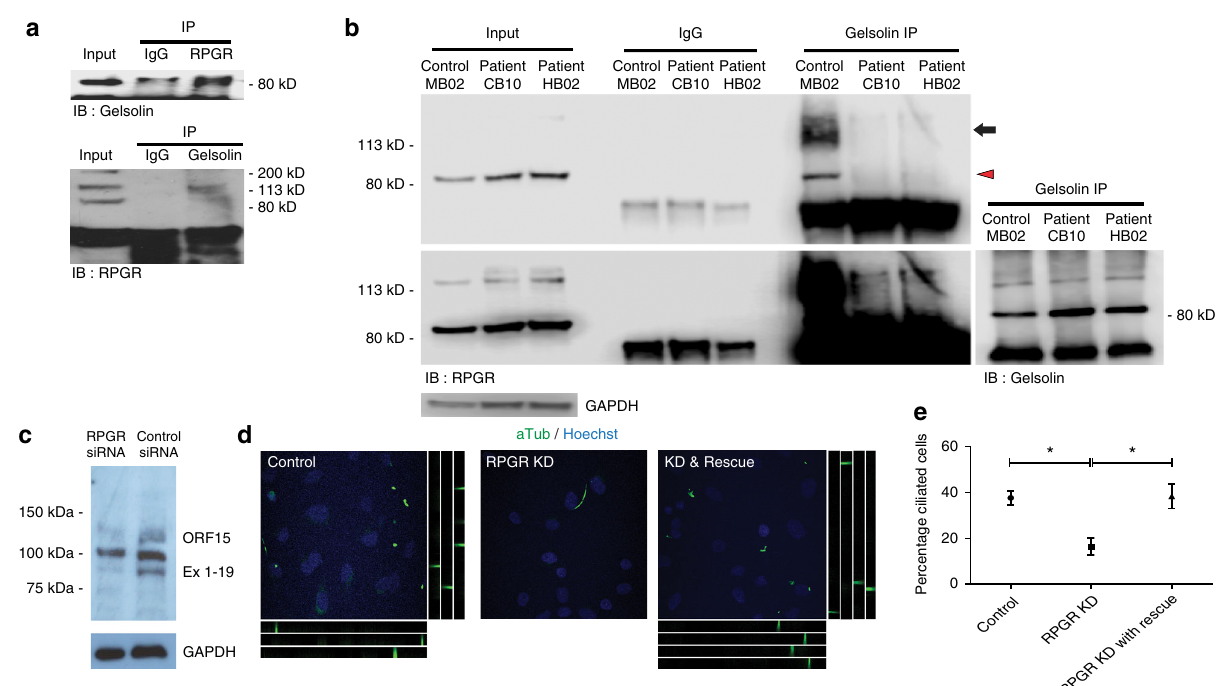
Fig. 6 Loss-of-function and gain-of-function experiments support a role for gelsolin in RPGR mediated cilia maintenance. a Immunoprecipitation (IP) of RPGR ( upper panel) and gelsolin ( lower panel) demonstrates an endogenous RPGR-gelsolin interaction in bovine retina, as evidenced by immunoblotting (IB) showing the presence of gelsolin (86 kD) and the 127 kD retina-speci fi c form of RPGR respectively in the immunoprecipitates. b Immunopreciptation (IP) of gelsolin followed by immunoblotting (IB) for RPGR reveals that the RPGR-gelsolin interaction is present in control iPSC-derived photoreceptors but is perturbed in both XLRP patient-derived RPGR -mutant cultures — note in the righthand set of three lanes that RPGR is present only in the IPs from the control patient. The lower panel shows a longer exposure of the immunoblot to show that both the constitutively-expressed (90 kD, encoded by exons 1 – 19, arrowhead) and retina-speci fi c (127kD — encoded by exons 1 – 14 and speci fi c open reading frame ORF 15, arrow) forms of RPGR are present in the control and mutant cell lysates shown in the three left hand lanes. Far right panel shows equal amounts of gelsolin are pulled down from each sample by gelsolin IP. c siRNA-mediated RPGR knockdown. Note that expression of both the constitutively-expressed (90 kD — Ex 1 – 19) and retina-speci fi c (127 kD — ORF 15) forms of RPGR are reduced by the siRNA while the non-speci fi c band at 100 kD is unaffected in the hTERT-RPE cell line. d , e Immmunolabeling of the hTERT-RPE cell line after siRNA-mediated RPGR knockdown reveals a loss of ciliogenesis (Mean percentage of ciliated cells 37.62% ± 3.113 vs 16.48% ± 3.762 (SEM), unpaired two-tailed t -test, p = 0.0124; identi fi ed by acetylated α -tubulin immunoreactivity in green), as shown by a comparison of the control ( left ) and RPGR knockdown ( centre ) panels. The defect is rescued by overexpression of constitutively active gelsolin, as shown in the right panel (Mean percentage of ciliated cells 16.48% ± 3.762 vs 38.33% ± 5.349 (SEM), unpaired two-tailed t -test, p = 0.0288.) The tracks below and to the right of the micrographs in d show z -planes of the image to con fi rm the presence of elongated cilia. Scale bars : 10 μ m ( d Secondary antibodies (all Life Technologies; all 1 in 1000 dilution unless Photoreceptor differentiation . Three-dimensional optic cup structures protocols otherwise stated): donkey anti-mouse-Alexa488 (A21202), donkey anti-mouse- were adapted from previous protocols 11, 12 . Con fl uent iPSC colonies were Alexa568 (A10037), donkey anti-goat-Alexa488 (A21432), donkey anti-goat- Alexa555 (A11055), donkey anti-sheep-Alexa488 (A11015), donkey anti-sheep- Alexa568 (A21099), donkey anti-rabbit-Alexa488 (A10042), donkey anti-rabbit- Alexa568 (A21206), Horseradish peroxidase rabbit (NA934V, GE Healthcare; 1 in 10000 WB) or Mouse (NA931V, GE Healthcare; 1 in 10,000 WB). siRNA duplexes (all with dT overhangs) were purchased from Sigma-Aldrich: control siRNA: 5 ′ -UUCUCCGAACGUGUCACGU-3 ′ ; RPGR siRNA: 5 ′ - GAGAUAGAUAAUUCUUCAA-3 ′ 6 . Constitutively active gelsolin (Ch- gelsolN ) was a gift from Ikuo Wada (Addgene plasmid #37262) 24 .